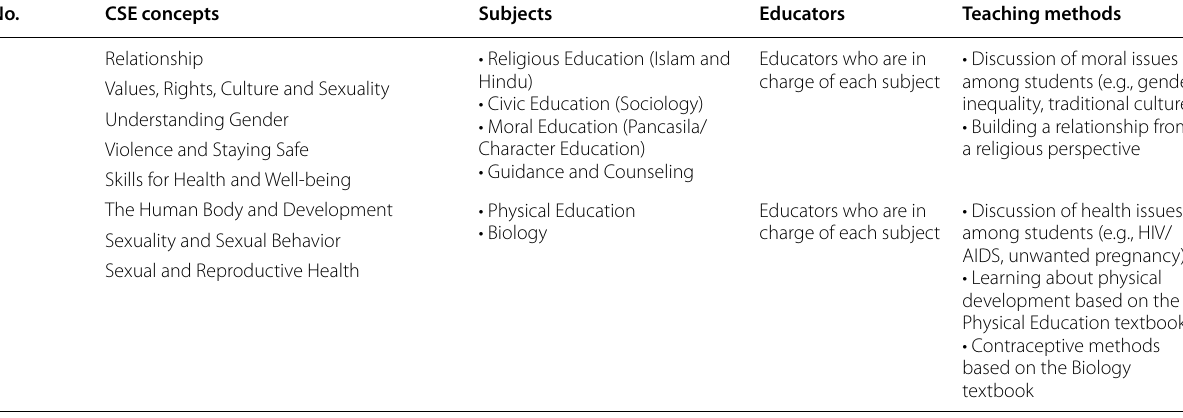
Table 4 Structure of CSE implementation based on eight concepts